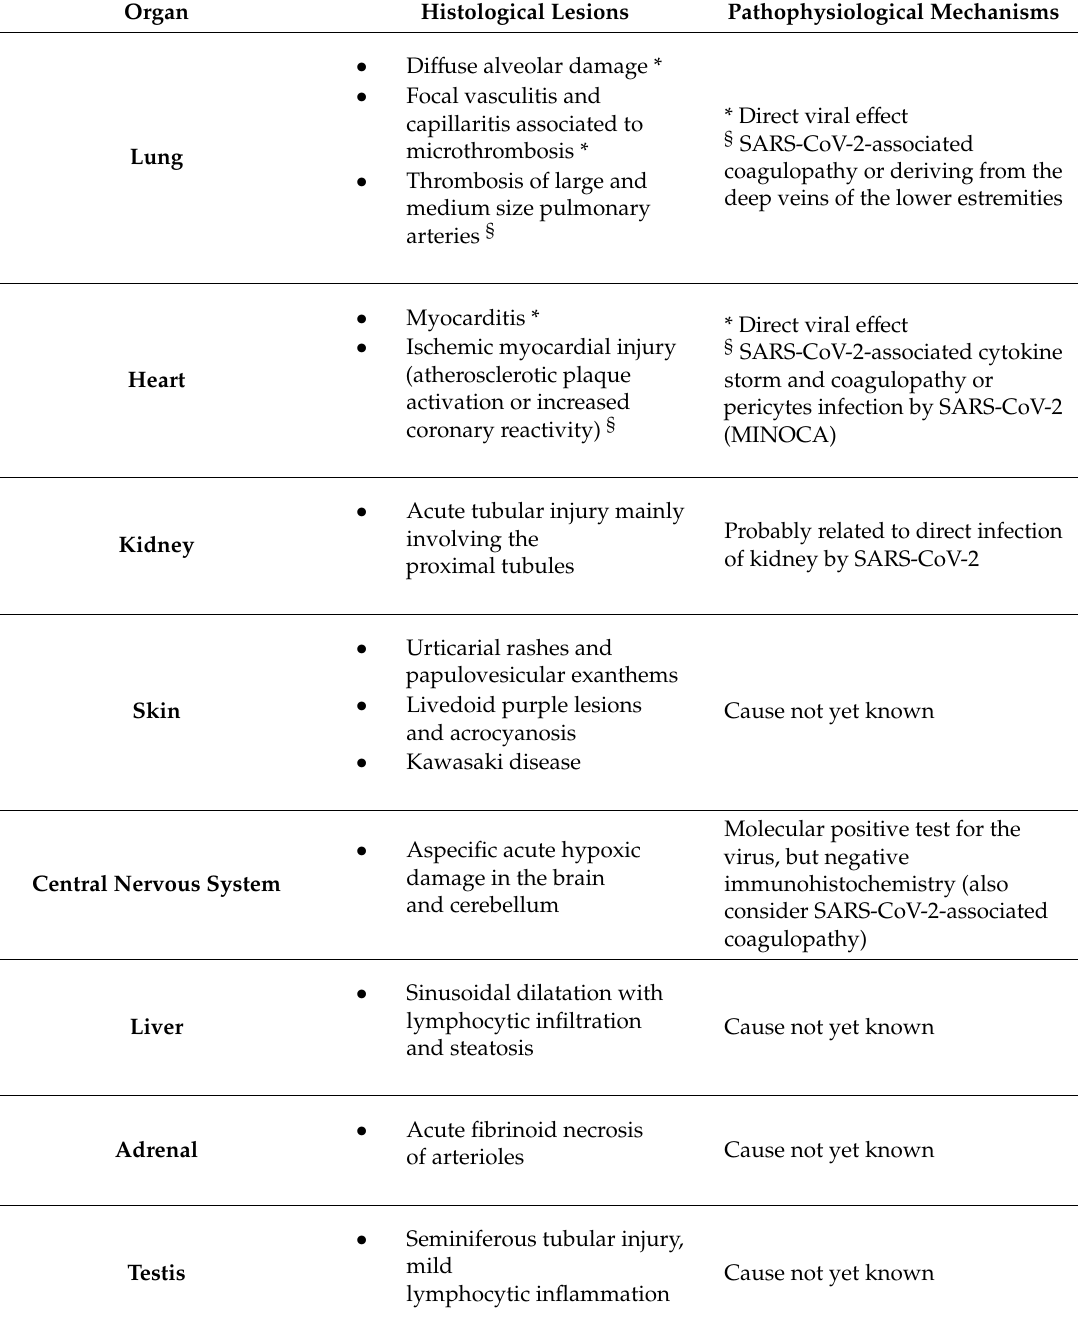
Table 1. Most important histological lesions observed during autopsy of patients who died from SARS-CoV-2 infection and related hypothesized pathophysiological mechanisms. * indicates the histological lesions recognizing the direct viral infection as pathophysiological mechanism; § indicates the histological lesions recognizing a pathophysiological mechanism other than the direct viral